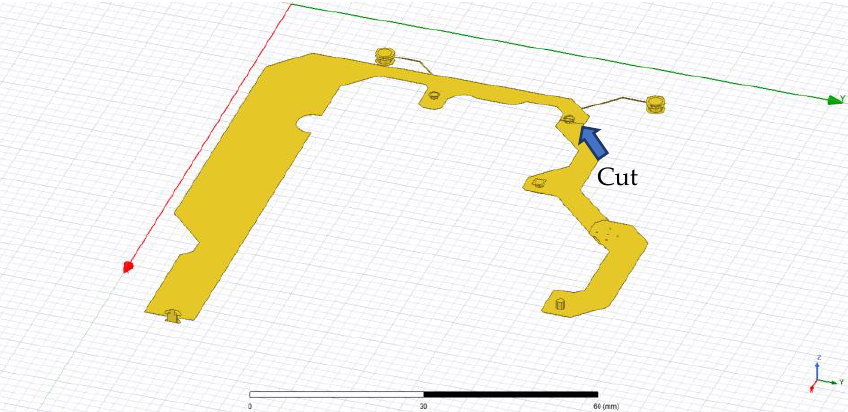
Figure 13. An example of a path division. The path between the ferrite core and input capacitor is divided into two parts: ferrite core – transistor drain and transistor drain – input capacitor.